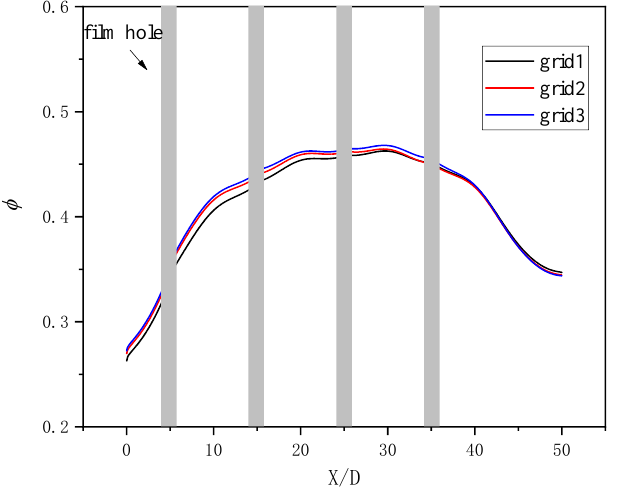
Figure 3. Mesh generated near the film hole at α = 30° with purple representing the fluid domain mesh and brown representing the solid domain mesh.